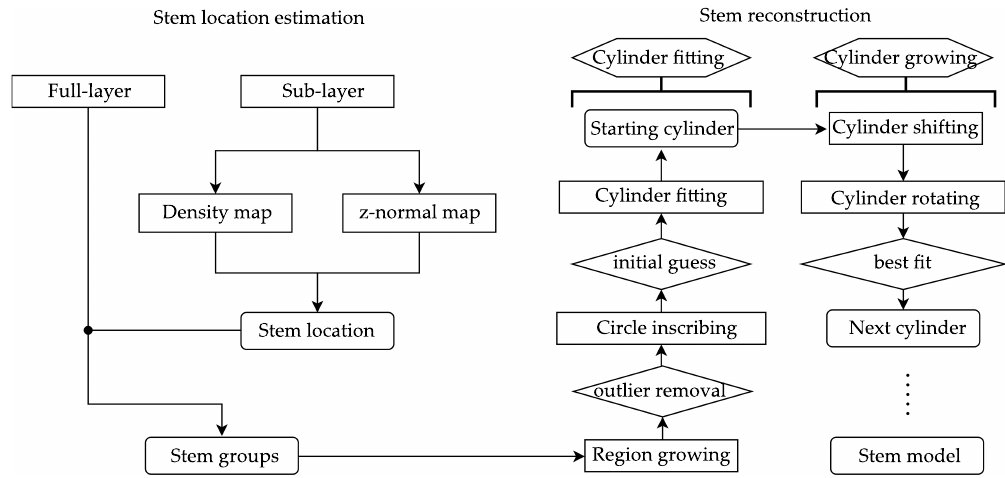
Figure 3. Workflow of our algorithms. Terrain removal is a preliminary procedure; thus, it is not shown